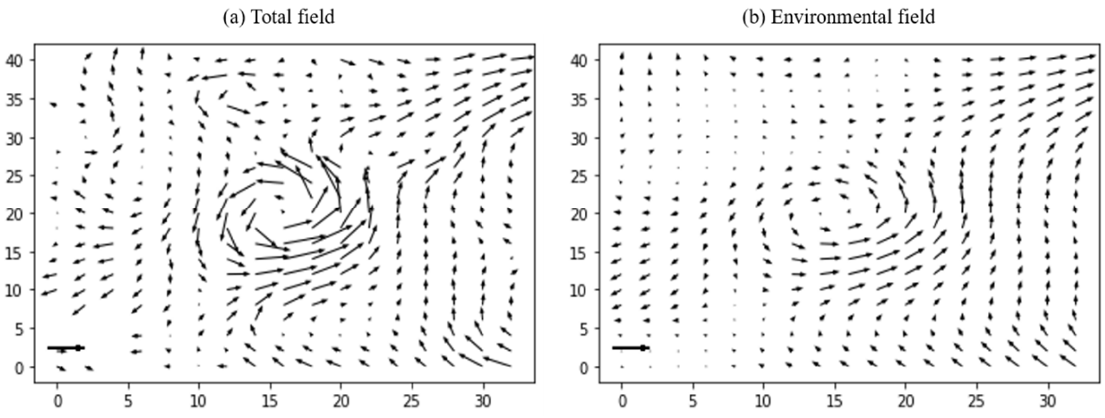
Figure 2. The total wind field ( a ) and environmental wind field ( b ) at 850 hPa for hurricane ALLI at 0600UTC, 3 July 1994.